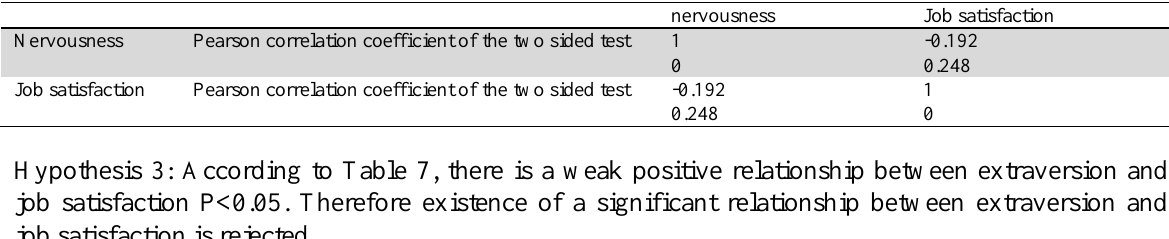
The results of Pearson correlation test for the third hypothesis